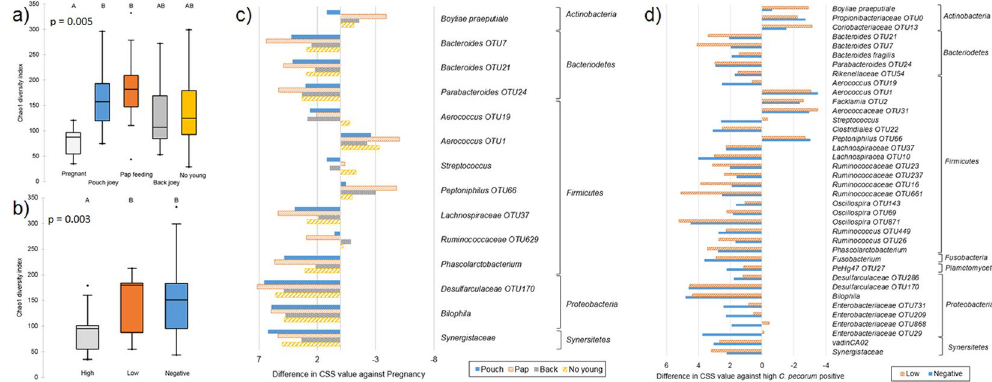
Figure 3. Comparative analysis of the influence of biological variables on female koala UGT microbiota for alpha-diversity and OTUs, with statistical significance (p < 0.05) as inferred by Kruskal-Wallis test. Box- plot of Chao1 diversity metric for ( a ) reproductive status, and ( b ) C . pecorum infection status-3. Bargraph of differences in OTUs values that have been normalised by CSS for ( c ) reproductive status, and ( d ) C . pecorum infection